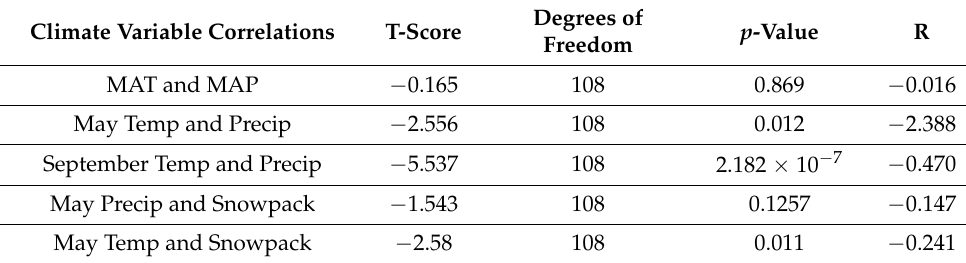
Table A2. Shows consistently significant p -values for the Shapiro-Wilkes test, which indicates that data is not normally distributed. Shapiro Test p -Values Phylo. All Trees